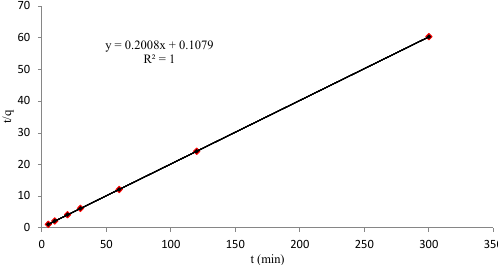
y = 0.2008x + 0.1079 R²=1